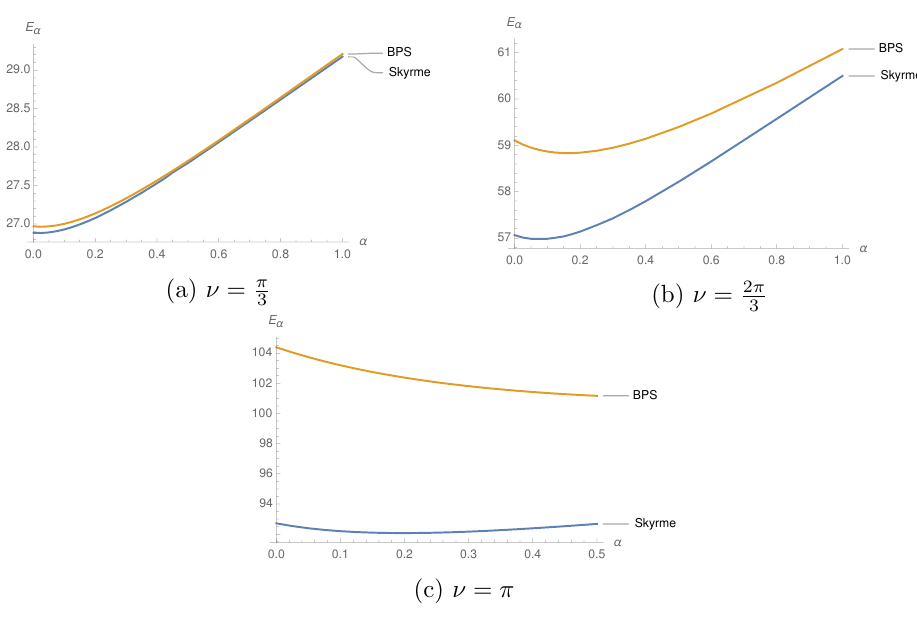
Figure 4. The phase diagrams for the energies of Skyrme and BPS monopoles with (cid:23) = (cid:25) and (cid:25) , for varying (cid:11) (cid:21)